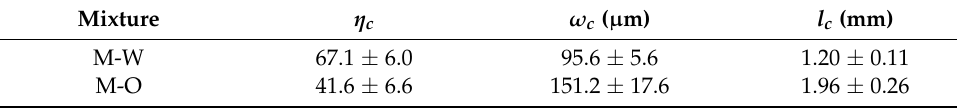
Figure 5. Cracking patterns of: ( a ) M-W and ( b ) M-O mixtures. Table 6. Detailed information on cracking patterns of SHCC.